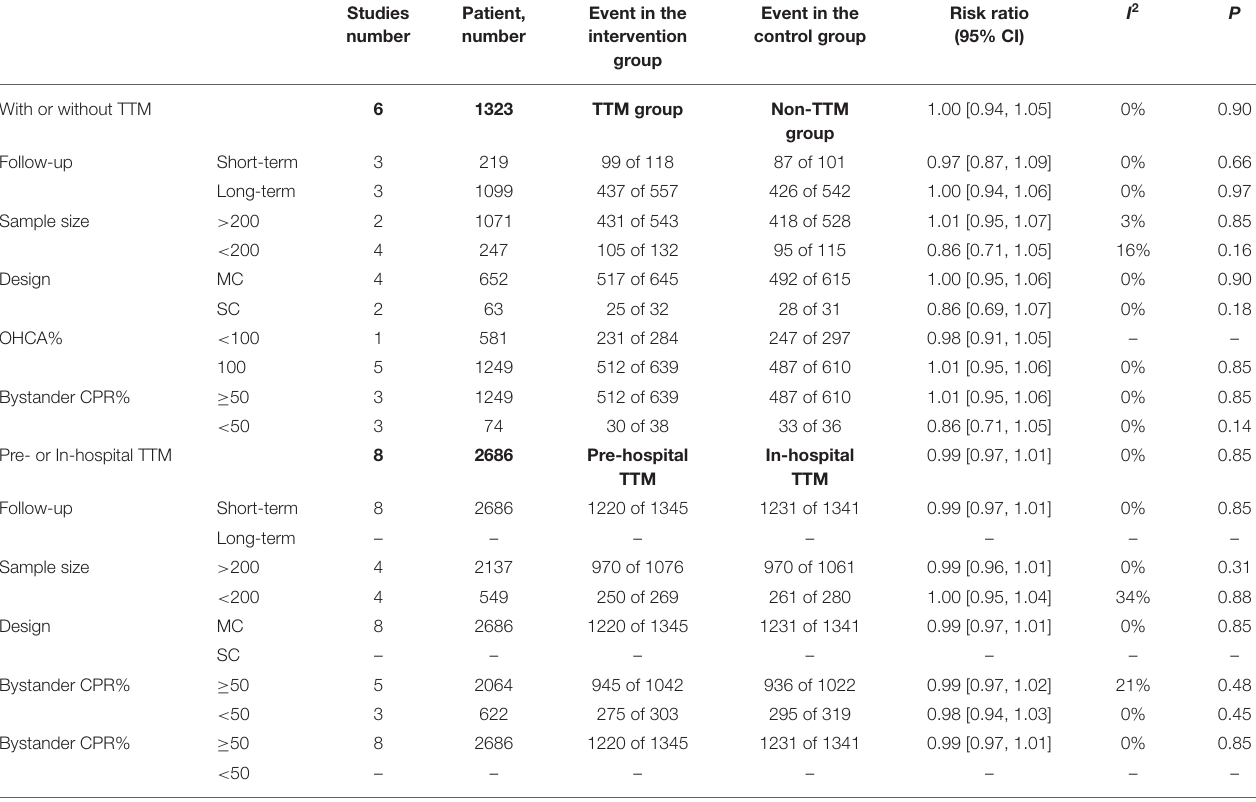
TABLE 3 | Subgroup analysis of the primary outcome based on TTM strategy.